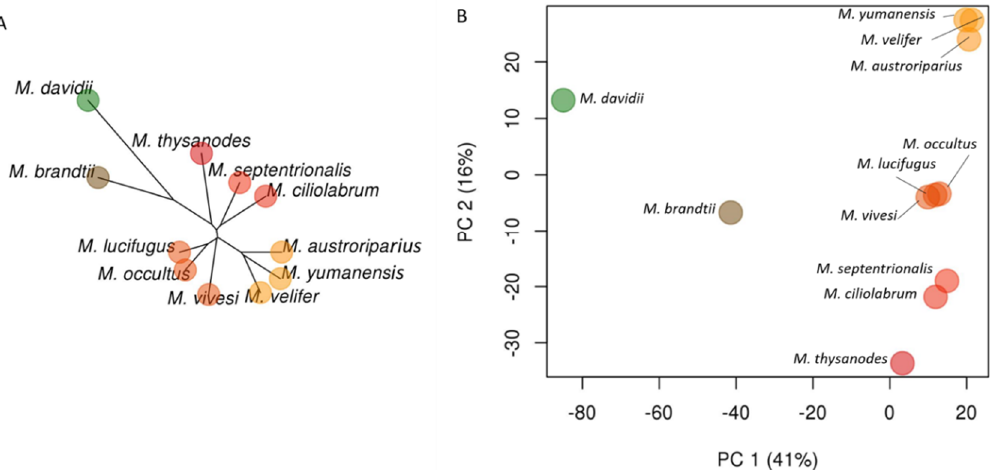
Figure 3. Genetic structure within Myotis as revealed by 10,595 orthologous Ves insertion events. ( A ) Unrooted neighbor-joining tree based on Ves insertions. ( B ) Scatterplot of the first two principal components (PC1 and PC2) illustrating differences among Myotis genomes. Percentages indicate percent of variation explained by each principal component shown. Colors in both figures are determined by PC values.